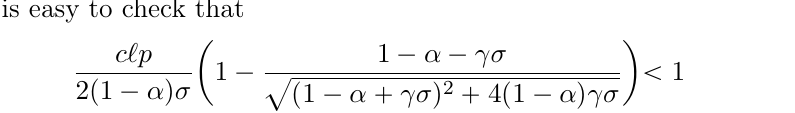
Fig. 6. Plots of the discretized model (20)–(21) with the step size l=100,